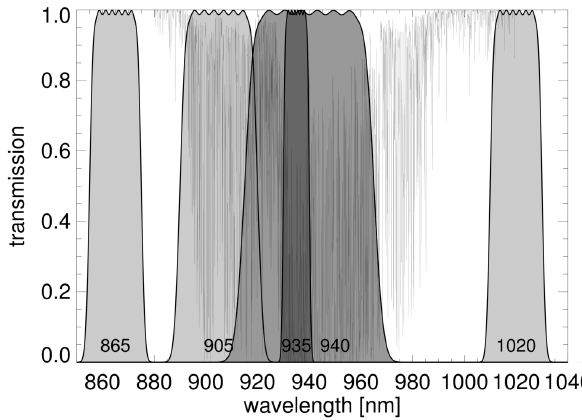
Fig. 2. METimage original channel constellation in the NIR (nor- malized response functions) and total transmittance of the atmo- sphere in ρστ -band.